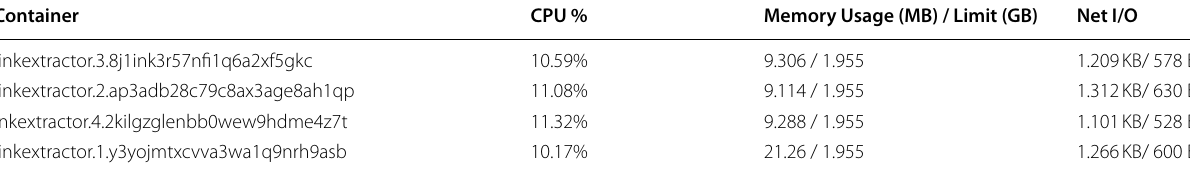
Table 2 Resource utilization by container instances (4)